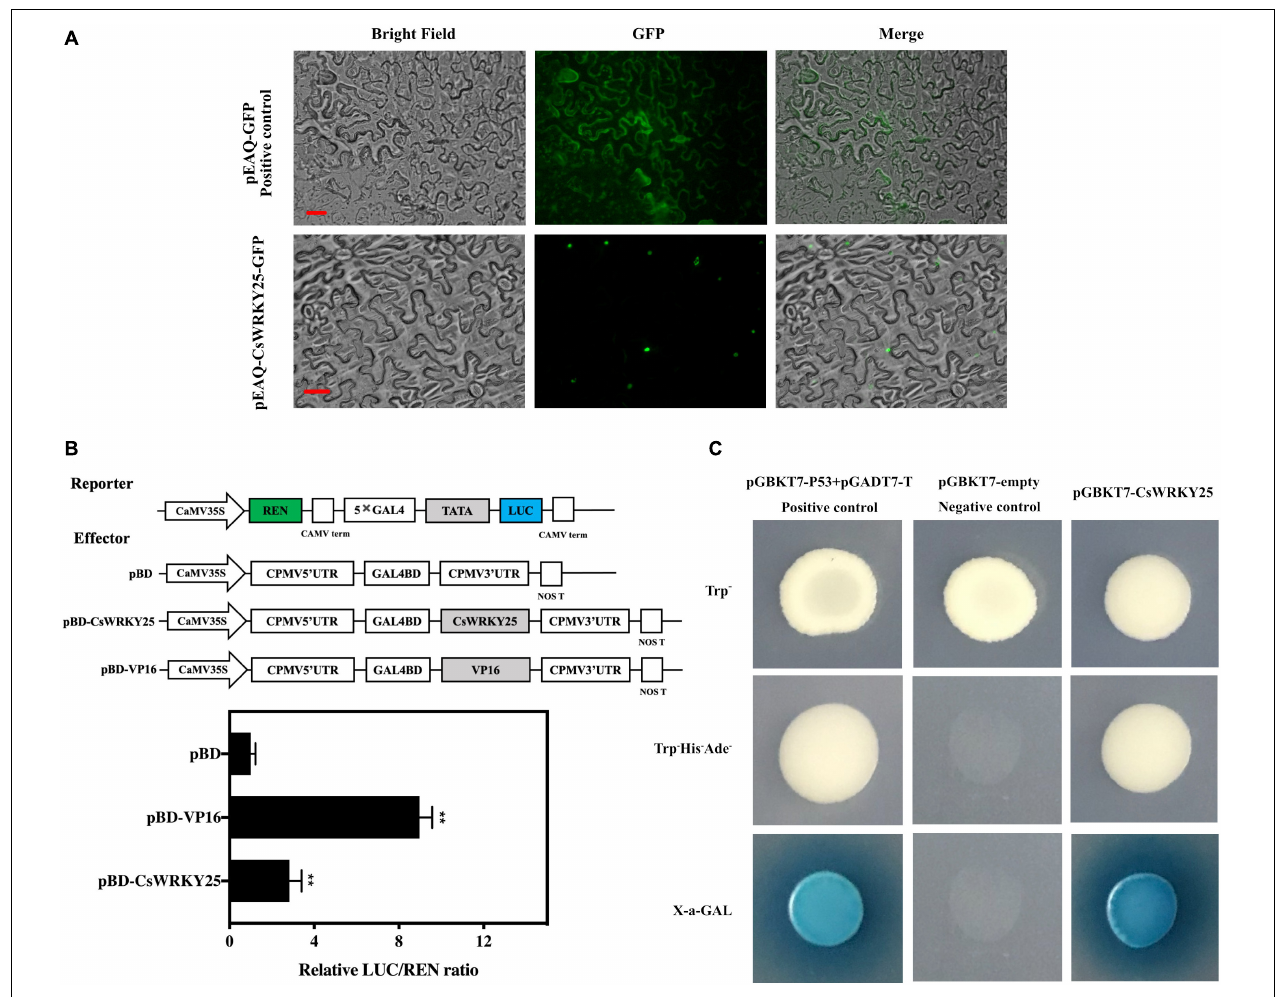
FIGURE 2 | Molecular Characterization of CsWRKY25. (A) Subcellular localization of CsWRKY25 in tobacco cells. Bars represent 25 µ m. (B) Trans -activation of CsWRKY25 in tobacco leaves. The ratio of LUC/REN of pBD control was used as calibrator (set as 1) and the pBD-VP16 was used as positive control. Values equal the mean ± SE ( n = 6). (C) Transcriptional activation of CsWRKY25 detected with the GAL4 yeast expression system. P values were regarded as statistically significant at ** P < 0.01.